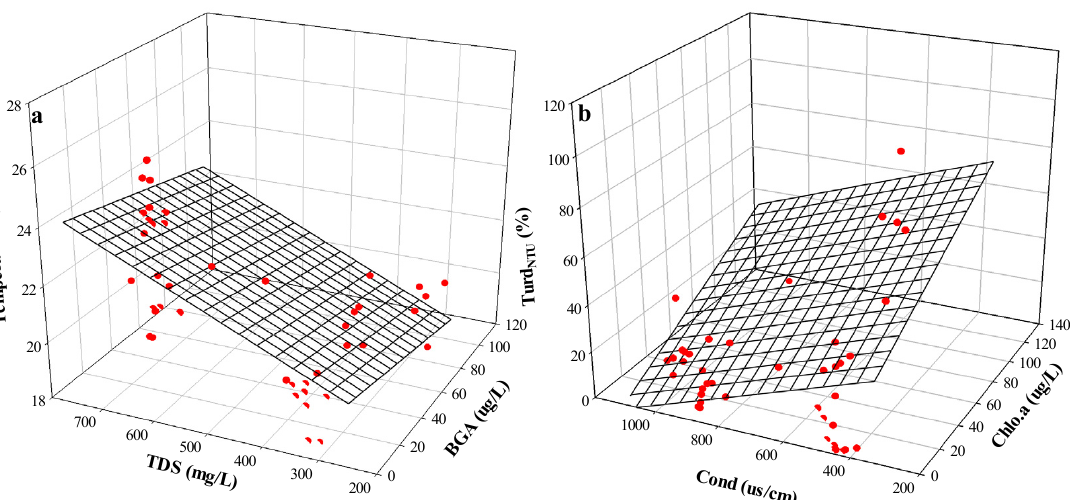
Figure 6. Effects of various inhibitors on algal growth. ( a ) represents the relationships among temperature, total dissolved nitrogen, and blue-green algae, and ( b ) the relationship among the turbidity NTU, chlorophyll a, and conductivity.